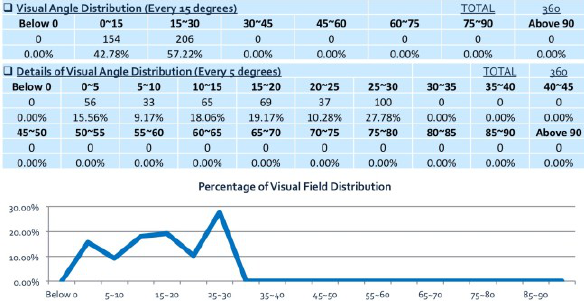
Figure 9. Visual Field Statistics for Central Campus Square , and Distribution of Visual Angles in 5-degree